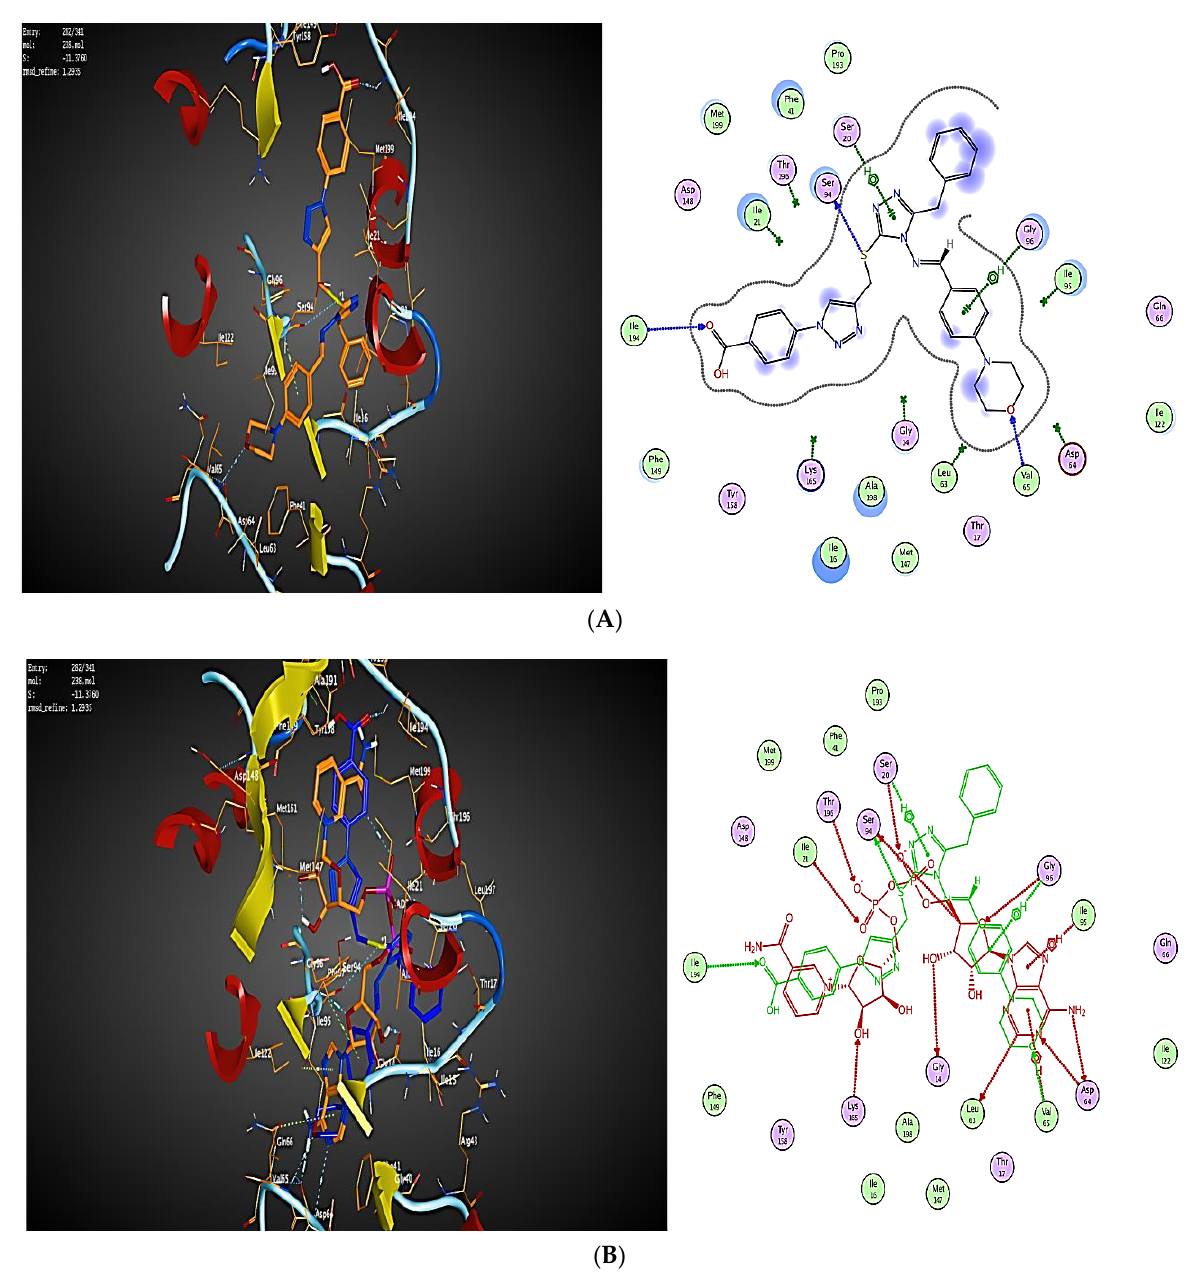
Figure 6. ( A ): Docking and binding pattern of compound 7c into inhA active site (PDB ID: 4TRO) in 2D (right panel) and 3D (left panel). ( B ): An overlay of the docked pose of compound 7c (brown) with the co-crystallized ligand (purple) into inhA active site in 2D (right panel) and 3D (left panel). Molecular docking studies of the target compound 7e displayed (S) − 11.7 kcal/mol and (RMSD) of 1.29 revealed that the 4-morpholino ring oxygen forms a hydrogen bond of 3.34 Å with Val65. Furthermore, 1,2,3 triazol-1-yl benzoic acid forms a hydrogen bond of 3.10 Å with Ile194 along the same track, 3-thio atom part in the linker forms a hydrogen bond of 3.70 Å with Ser94. Besides, 2 Hydrophobic π -H bond interactions were encountered between 1,2,4 triazole and 4-benzylidene ring of 3.79 and 4.89 Å with Gly96 and Ser20, respectively (Figure 7A,B).